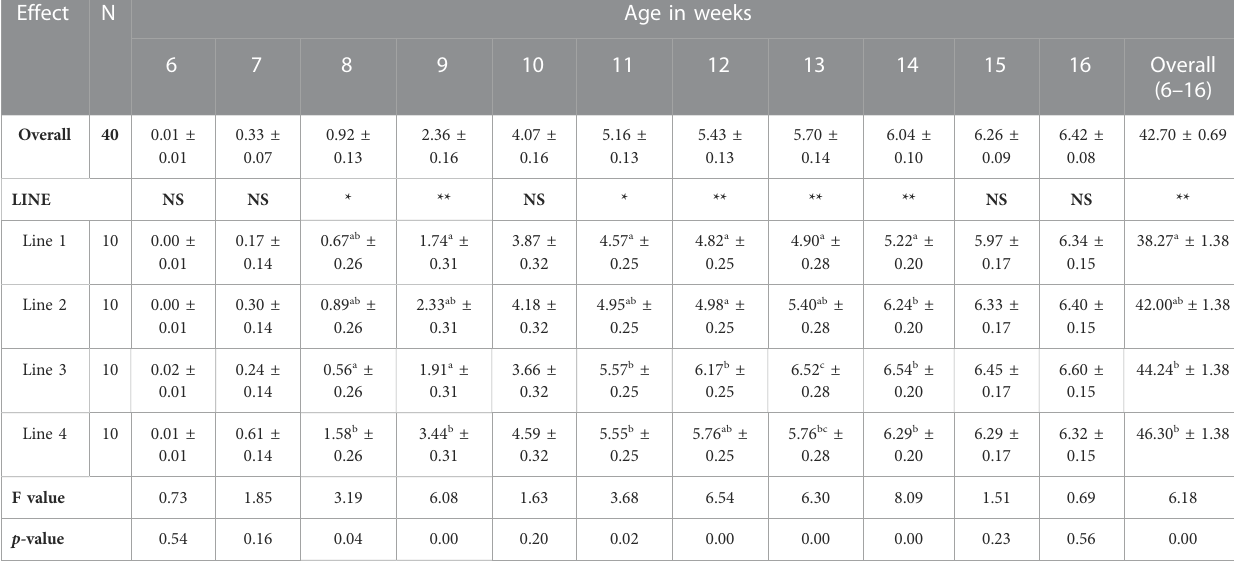
TABLE 5 Means (±S.E.) of hen-housed egg production (eggs per bird) of different lines of Japanese quail from 6th to 16th week of age.